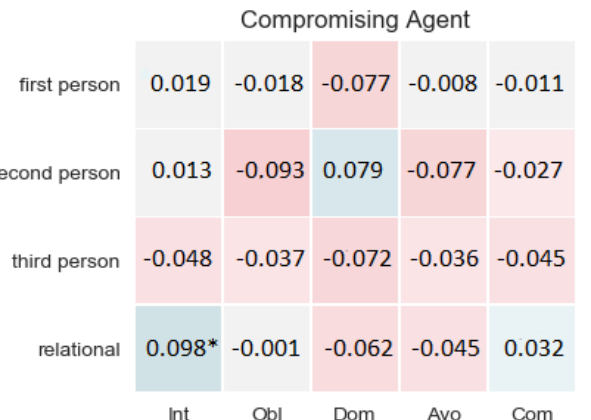
Figure 6. Correlation coefficients between first person, third person and relational pronouns used during the interaction with the Dominating virtual agent and the ROCI-II scores.